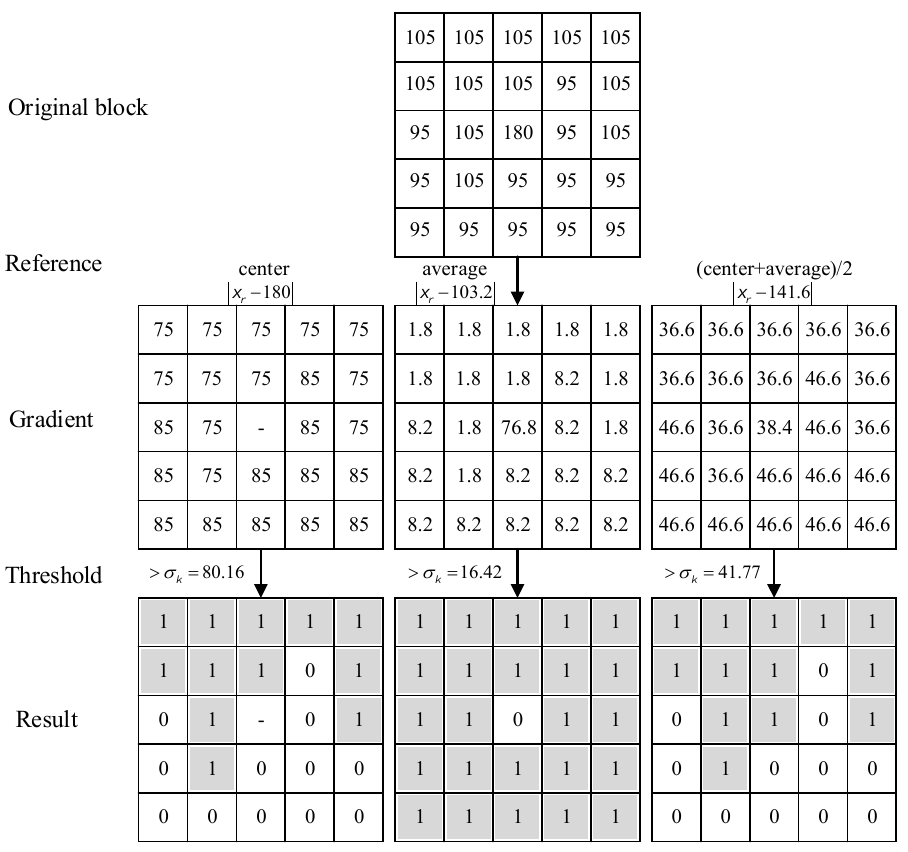
Figure 5. Reliability evaluation of locally distributed neighborhood pixels. The first line represents a local 5 × 5 neighborhood original block; the second line is the reference value for pixel comparison in the neighborhood; the third line provides the pixel values after the contrast difference in the neighborhood block; the fourth line shows the deviation threshold; the fifth line presents the result of reliability